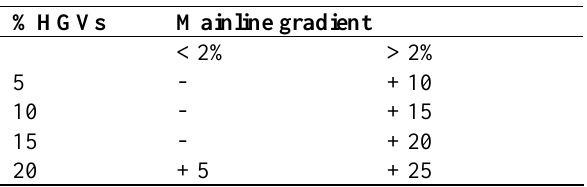
Table 3. Correction factors (%) within